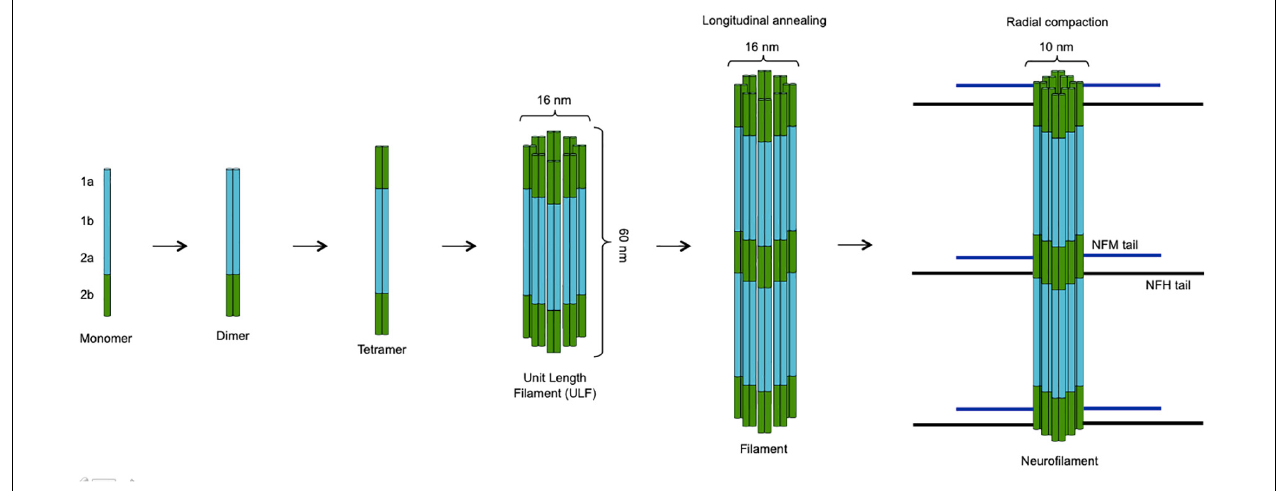
FIGURE 2 | Assembly of neurofilaments. Two neurofilament subunits combine to form a paired coiled-coil dimer, which then undergoes antiparallel association with another dimer giving rise to a non-polar tetramer. The circumferential association of eight tetramers produces a cylindrical unit length filament (ULF) with a diameter of 16 nm. ULFs undergo end-to-end annealing forming elongated filaments, whose radial compaction results in reduction of the diameter to the typical 10-nm size of intermediate filaments. While the backbone of the neurofilament scaffold is constituted by NFL plus α -internexin or peripherin (in the CNS and in the PNS, respectively), NFM and NFH molecules associate more peripherally with their long tails projecting outside and interacting with other cytoskeletal components (microtubules) and organelles (mitochondria). The figure was created taking Figure 4 from Yuan et al. (2017) as model, with the authors’ permission.